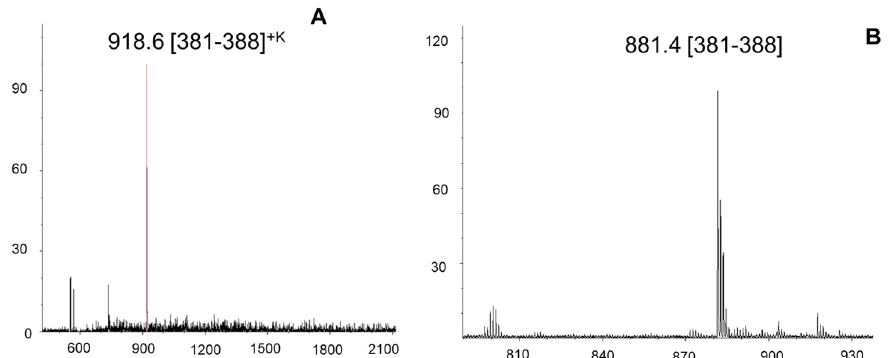
Figure 7. Epitope identification of the complex of the cancer diagnostic protein C-Met with the DNA-aptamer CLN-004 by tryptic epitope extraction from immobilized aptamer on CNBr activated Sepharose affinity column [69]. ( A ); SPR chip-MALDI-MS upon tryptic epitope extraction from immobilized CLN0004 on an SAM-coated SPR chip ( B ), MALDI-MS upon epitope extraction between C-Met and CLN0004 aptamer.